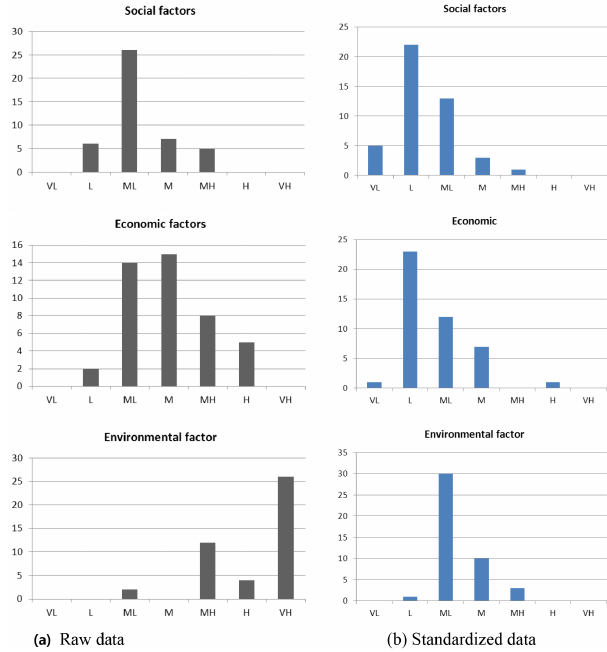
Figure 5. Comparison of original and standardized data.